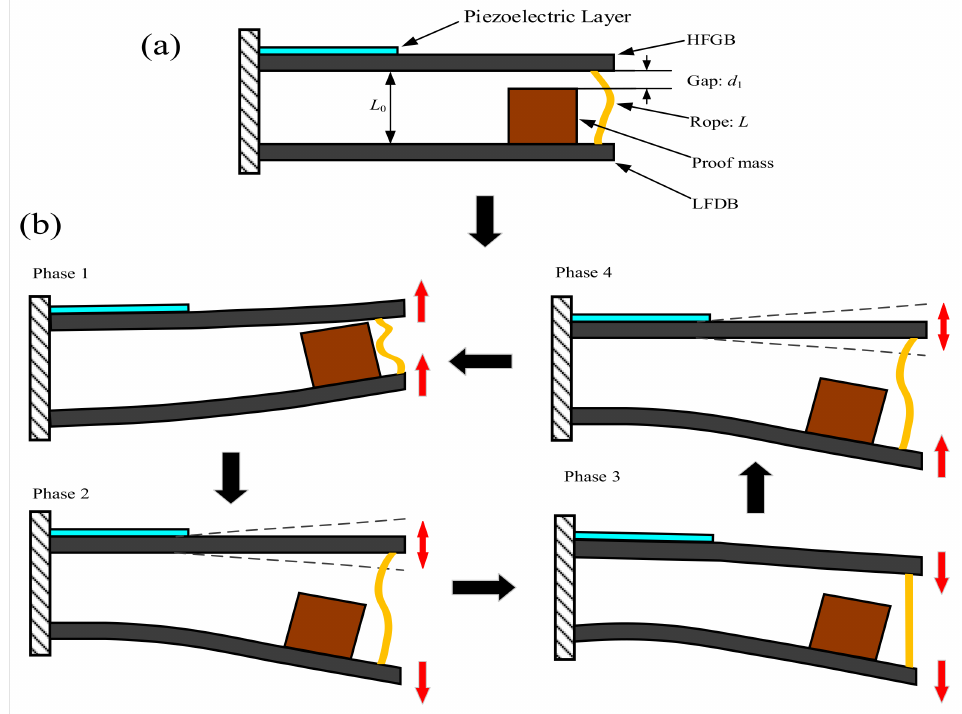
Figure 12. Architecture ( a ) and operation mechanism ( b ) of the proposed PVEH system [83].